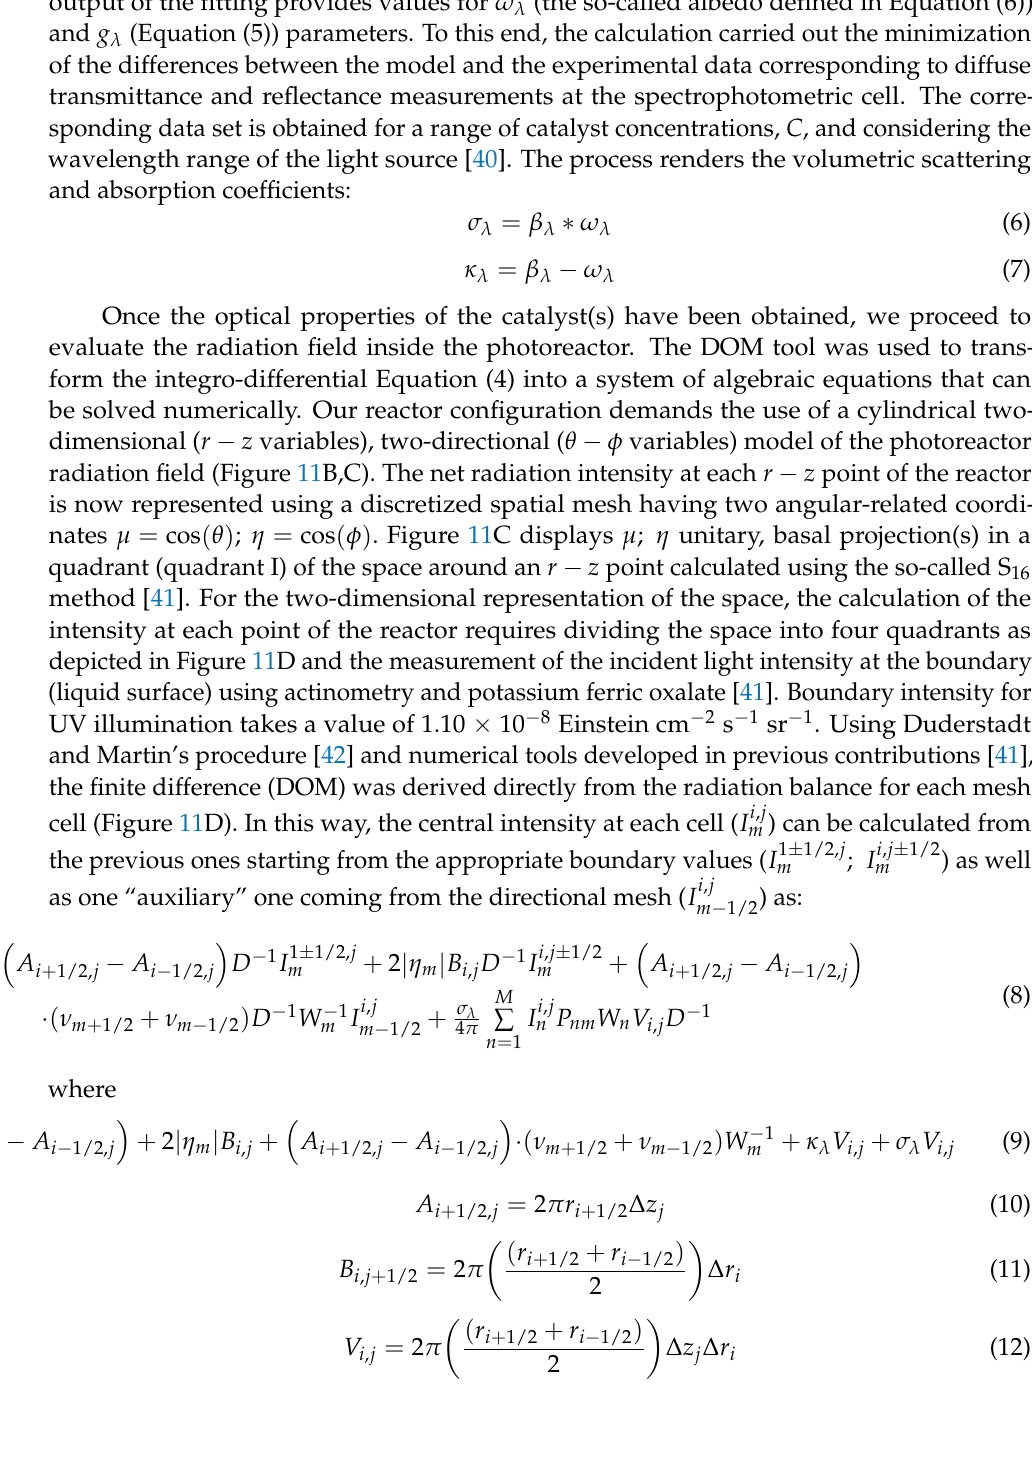
Figure 11A encloses a schematic representation of the spectrophotometer cell and the corresponding RTE solution scheme. The latter considers that each propagation path (departing from each point of the cell) of the net light intensity can be defined by a one angular-related variable ( µ = cos ( θ ) ), one-dimensional (x variable) representation. For each x point and starting from the corresponding boundary condition, the light intensity for pos- itive or negative µ values was obtained by solving a unidimensional DOM representation of Equation (4) in combination with a nonlinear, multiparameter least-square regression procedure (MATLAB lsqnonlin, Algorithm: Trust-Region-Reflective Optimization). An iterative process is carried out until error for all intensity values are lower than 1%. The output of the fitting provides values for ω λ (the so-called albedo defined in Equation (6)) and g λ (Equation (5)) parameters. To this end, the calculation carried out the minimization of the differences between the model and the experimental data corresponding to diffuse transmittance and reflectance measurements at the spectrophotometric cell. The corre- sponding data set is obtained for a range of catalyst concentrations, C , and considering the wavelength range of the light source [40]. The process renders the volumetric scattering and absorption coefficients: